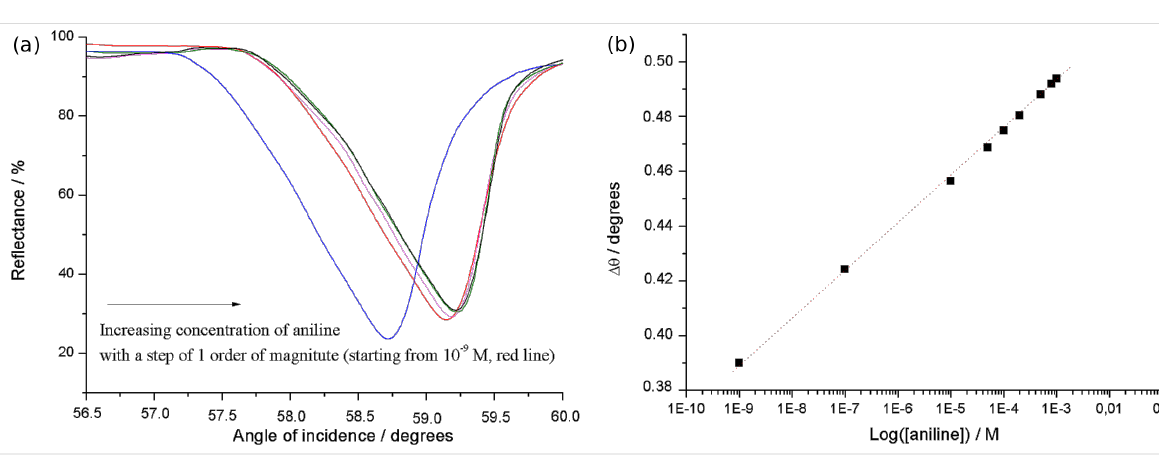
Figure 7: (a) Reflectance variation of Cu,H 2 -Por 2 LS films and (b) SPR angle shift as a function of analyte concentration.